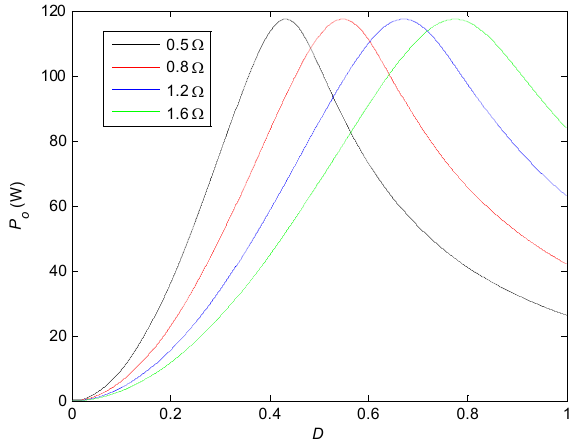
Figure 4. curves under different load conditions. Figure 4. Curves under different load